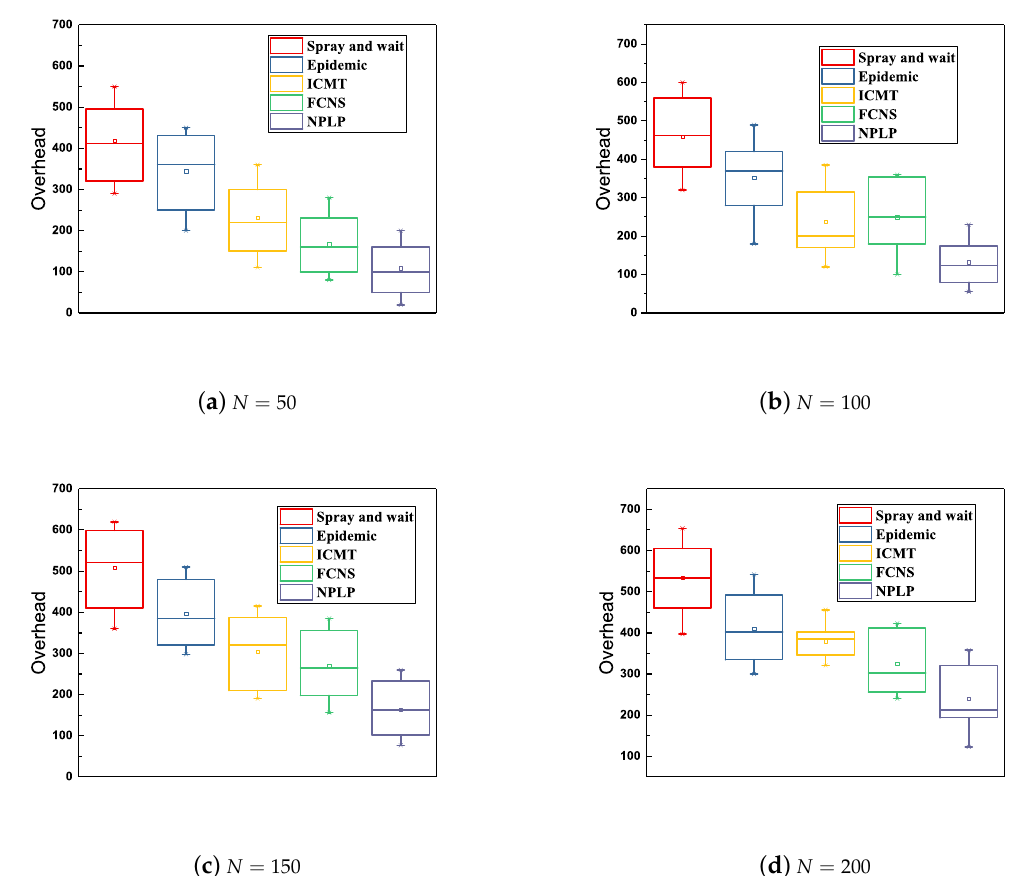
Figure 6. Performance comparison of overhead between five algorithms with various number of